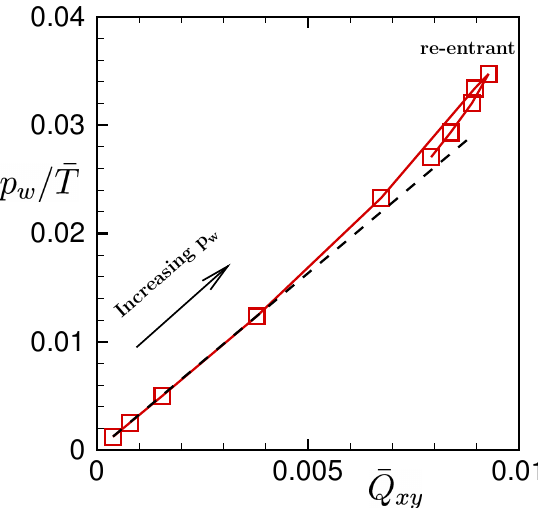
Figure 8. The stress–optical relation p w / ¯ T vs. ¯ Q xy . The drive force p w increases in the direction of the arrow. The re-entrant transition of the linear stress–optical relation is observed at large gross shear